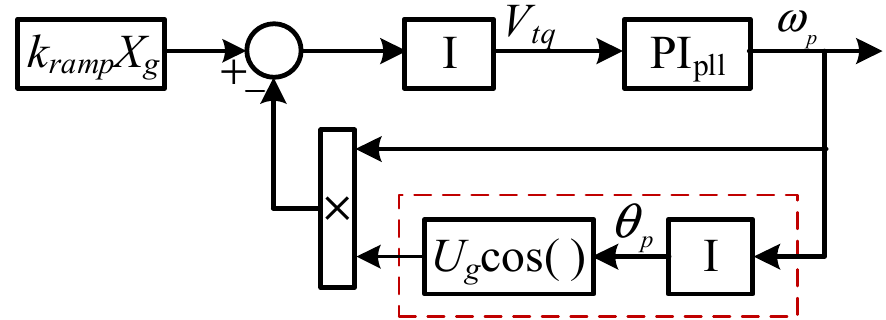
Figure 10. Frequency dynamics of internal voltage dominated by PLL.